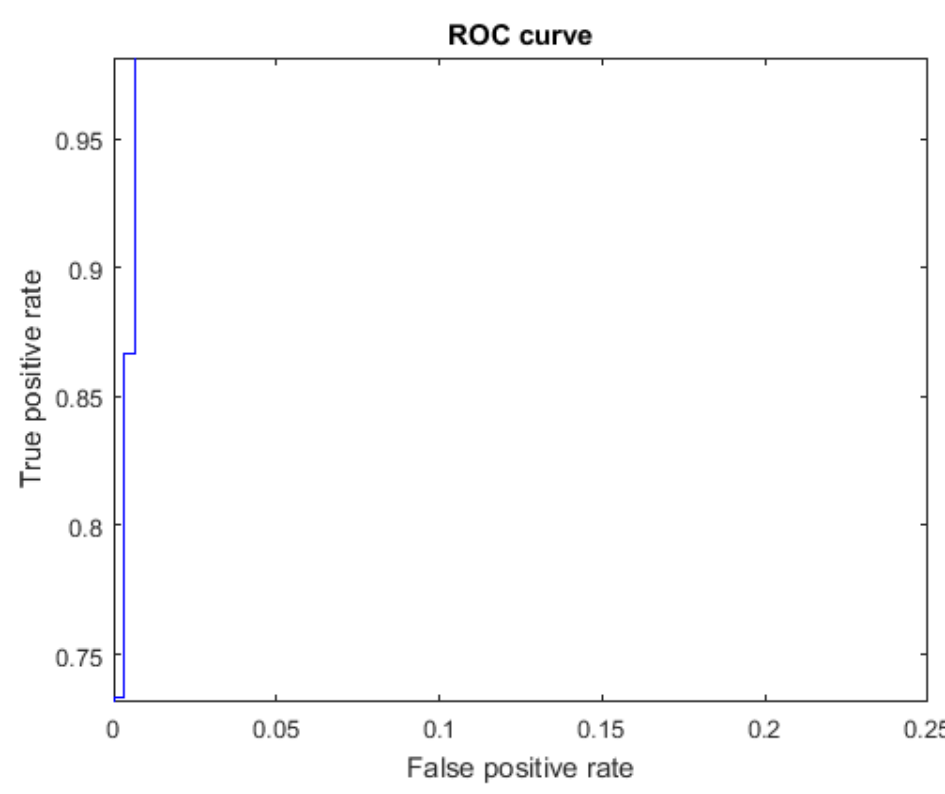
Figure 14. ROC curve for the letter F using Cartesian features, AUC = 0.9987.